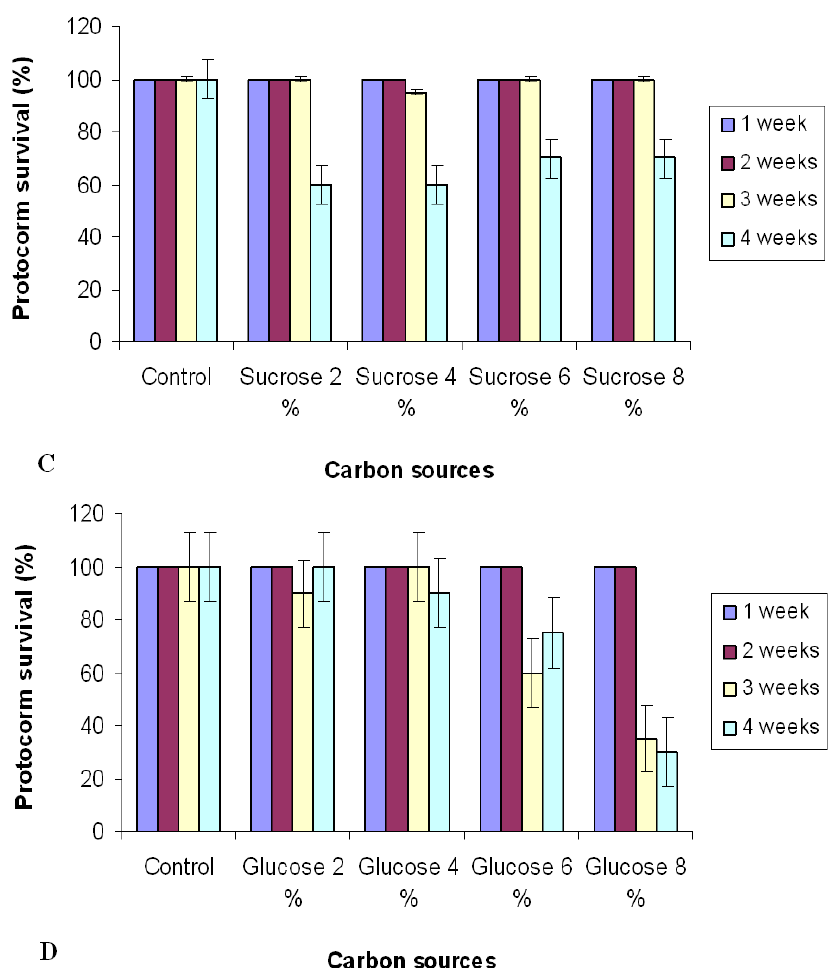
Fig. 2. Regeneration of protocorms after 4 weeks in media with different types and con- centrations of sugar. In each treatment 20 explants were studied. Bar = standard